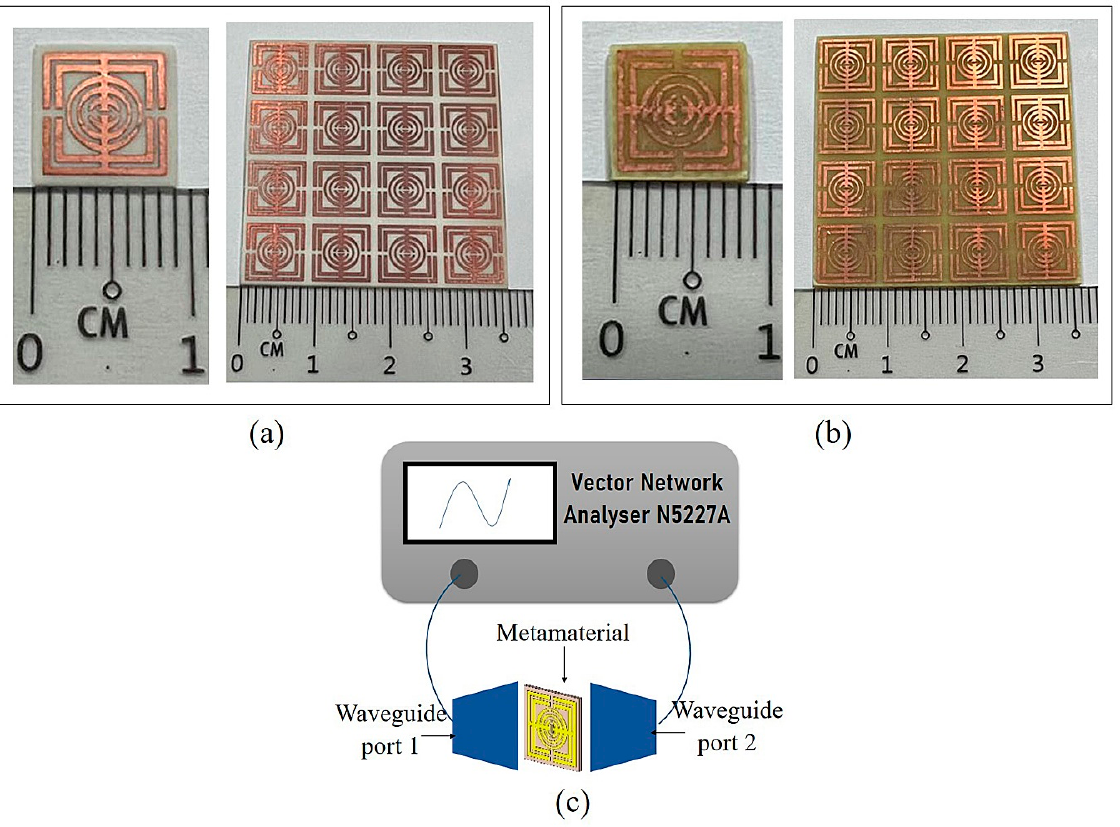
Figure 3. Fabricated unit cell and arrays metamaterial, ( a ) Rogers RO4003C, ( b ) FR-4 and the illustration of experimental set up, ( c ) VNA.